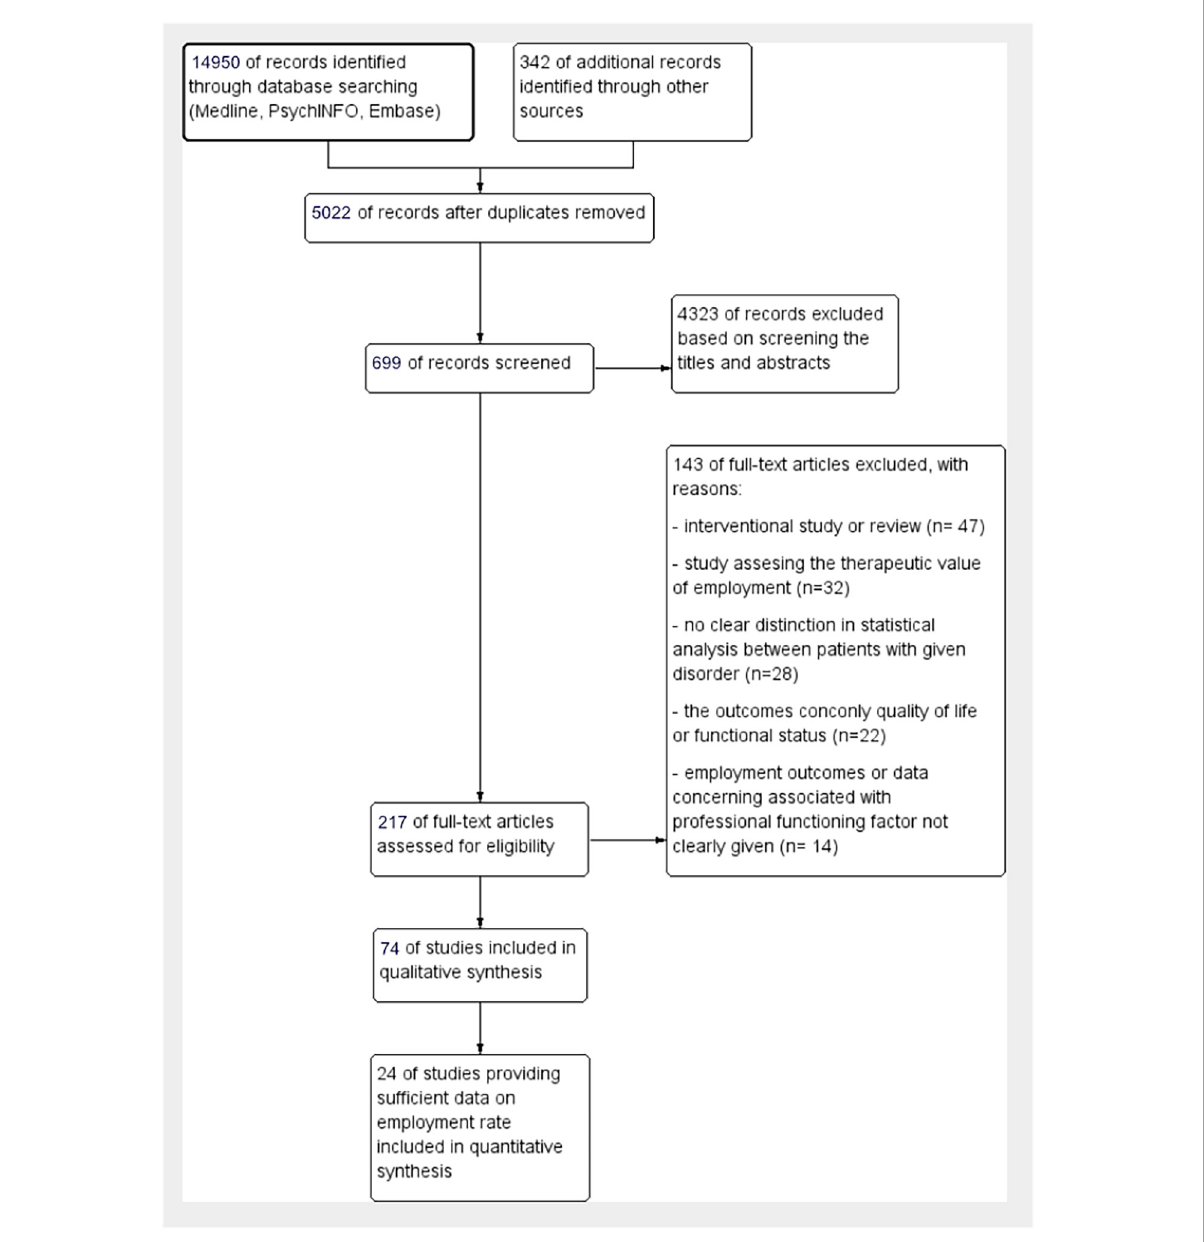
FIGURE4 Employment rate among BD population–subgroup analysis with regard to the severity of affective